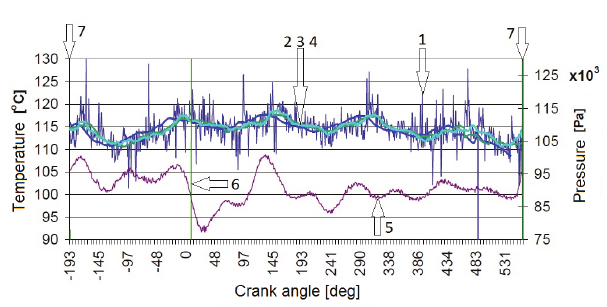
Fig. 5. Temperature change curves recorded in the exhaust channel of the Farymann D10 diesel engine with a type K thermocouple (grounded) during one of the work cycles filtered in Matlab; 1 – temperature recorded with a grounded thermocouple, 2 – temperature curve after the Savitzki and Golay filter, 3 – temperature curve after the median filter, 4 – tempera- ture curve after the envelope filter 5 – pressure in the exhaust channel, 6 –